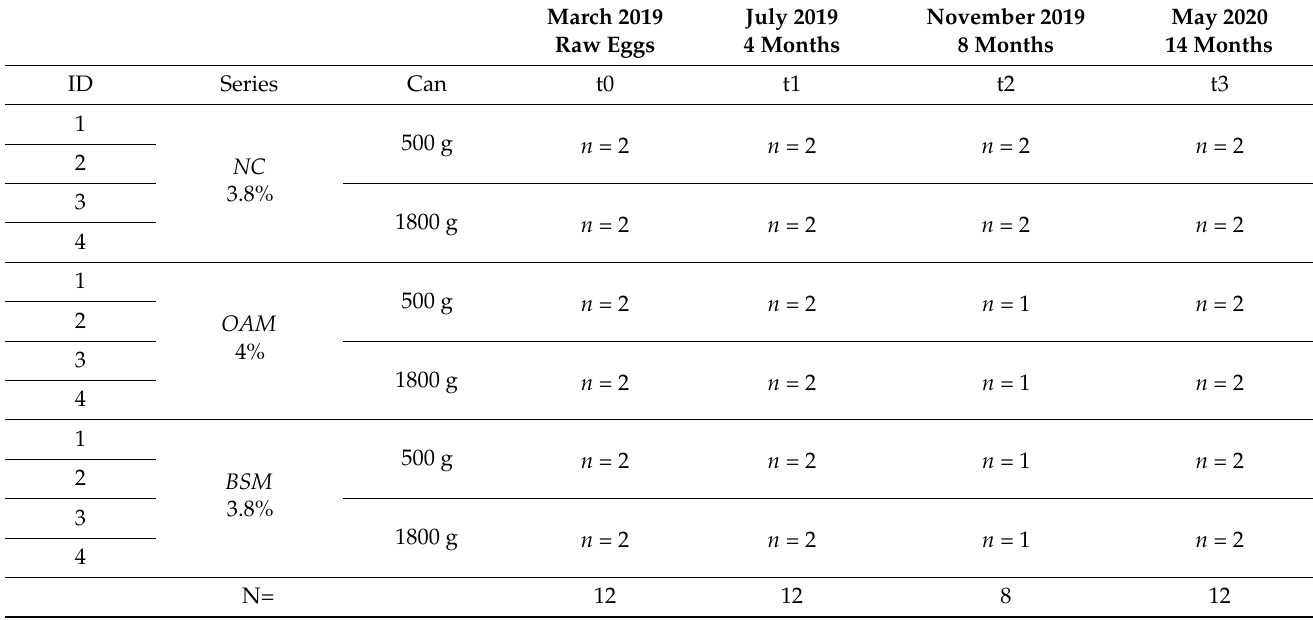
Table 1. Samples collection scheme. Legend: NC, sodium chloride (NaCl); OAM, organic acid mixture; BSM: borax and salt